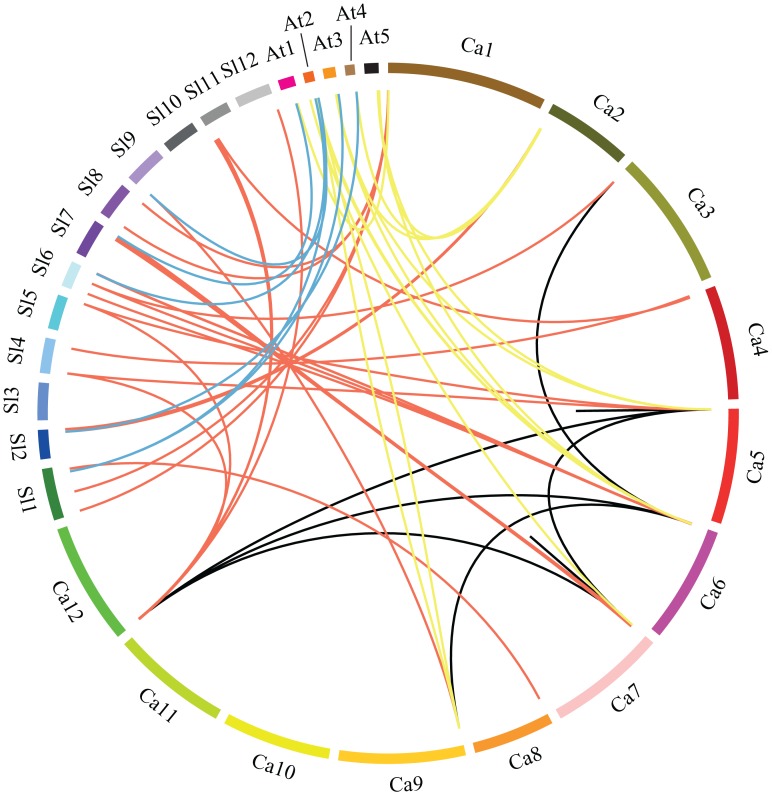
Microsynteny analyses of GRAS genes among pepper (Ca), tomato (Sl), and Arabidopsis (At).Red, yellow and blue lines connecting two chromosomal regions indicate syntenic regions between pepper and tomato, pepper and Arabidopsis, tomato and Arabidopsis chromosomes, respectively. Black lines denote segmental duplicated GRAS genes on the pepper chromosome.